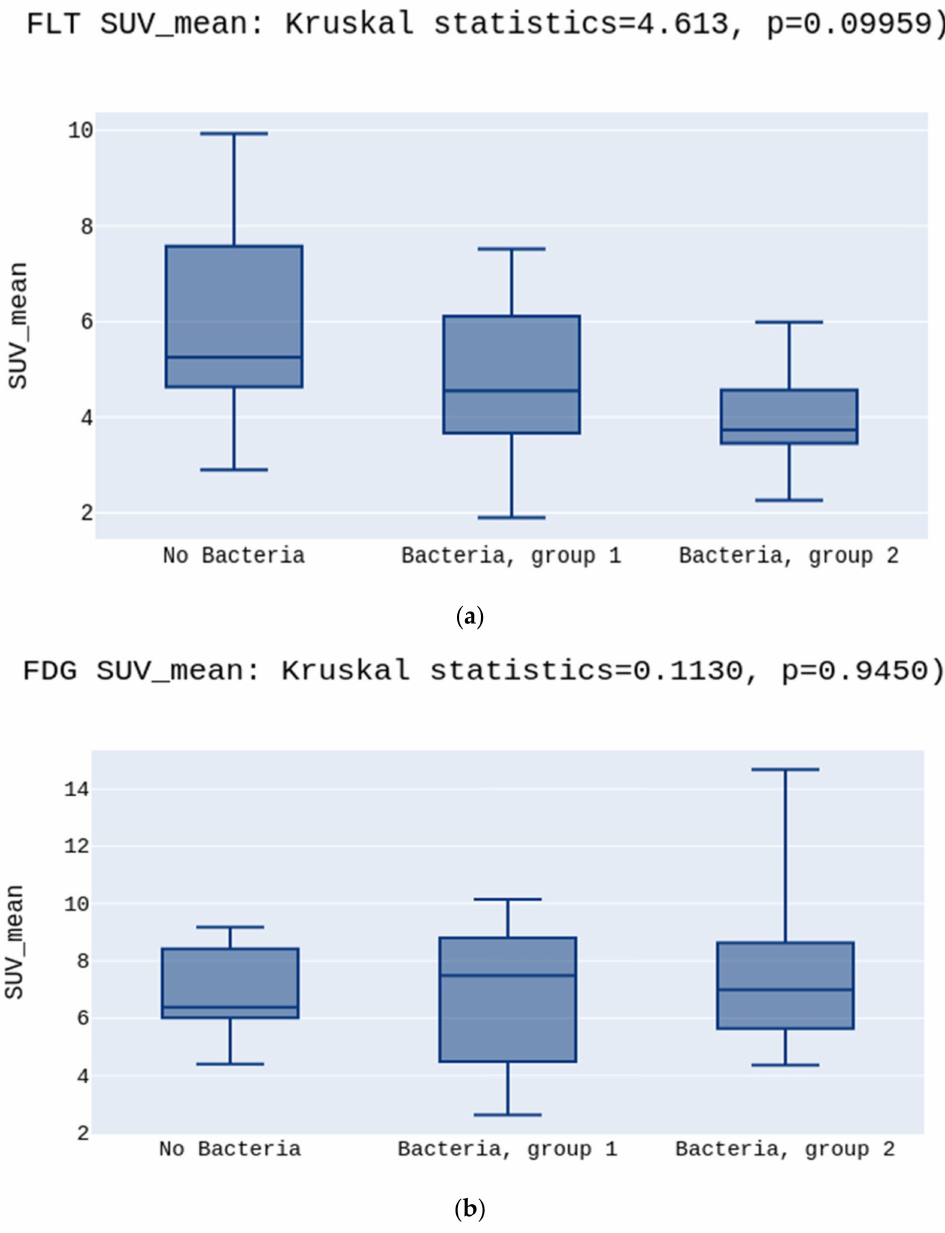
Figure 2. ( a ) presents no differences between SUV mean in the No Bacteria Group, Group 1, and Group 2 for the [ 18 F]FLT, p > 0.05. ( b ) presents no differences between SUV mean in the No Bacteria Group, Group 1, and Group 2 for the [ 18 F]FDG, p >